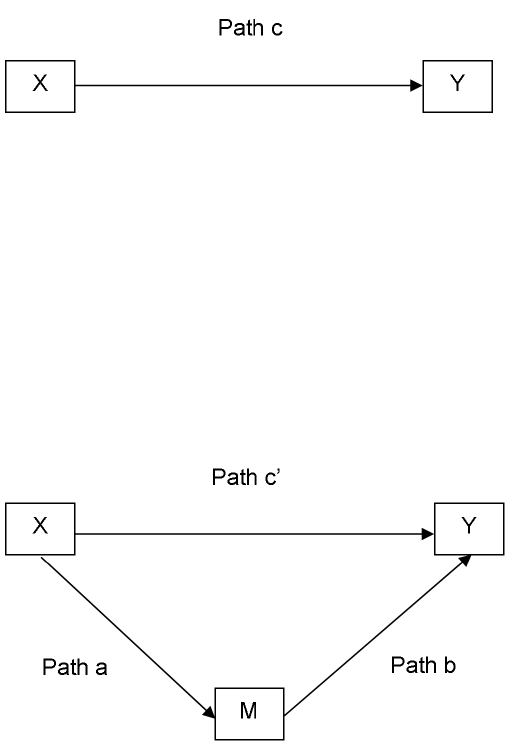
Figure 1. Conceptual model of the association between socioeconomic position (SEP) and takeaway food consumption and contribution of psychosocial factors to the association (adapted from [39]). X = the independent variable = SEP (education). Y = the outcome variable = takeaway food consumption (‘‘healthy’’ and ‘‘less healthy’’, each takeaway food type was examined separately). M = the proposed mediating variable = psychosocial factors (nutritional knowledge, belief about the diet-health relationship, perceived value of takeaway food, and takeaway foods as pleasure), each psychosocial factor was examined separately. Indirect (mediated) effect = a x b = c – c’.